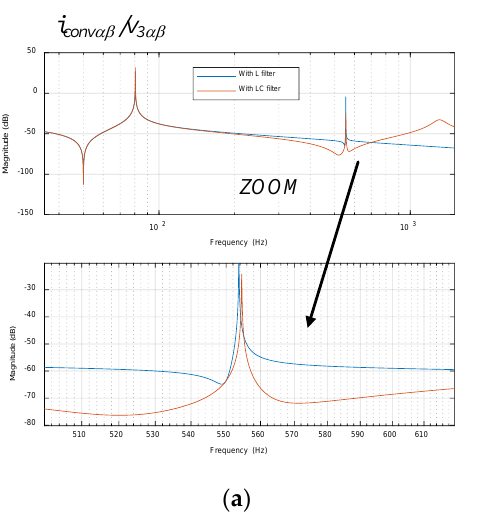
Figure 2. Bode plots with the ACISEF with L and LC output filters and active resistance ( R v 1 = 1.51 k Ω programmed at 550 Hz). ( a ) Bode diagram of i convαβ / v 3 αβ , ( b ) Bode diagram of v 3 αβ ( s )/ v sαβ ( s ).